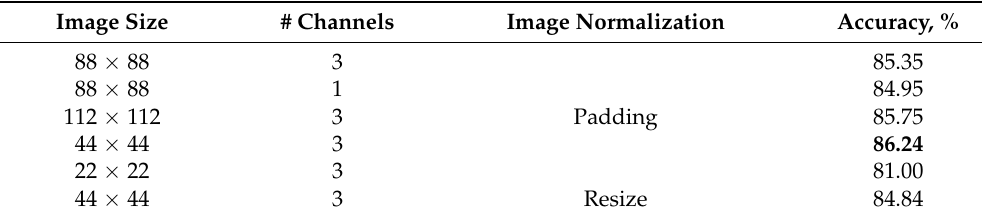
Table 4. Accuracy results of choosing the optimal input image